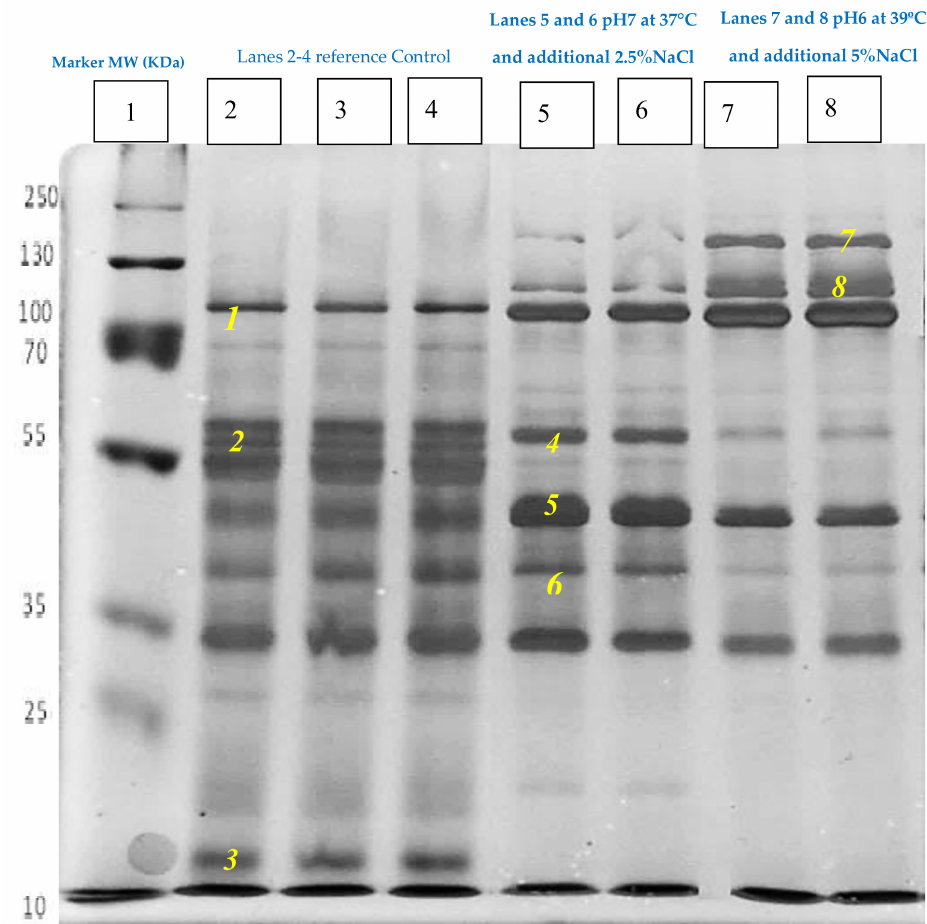
Figure 6. SDS-PAGE analysis of the stationary phase secreted proteins of S. aureus grown under the control conditions, compared with the two di ff erent experimental treatments. The numbers indicate the bands that were sliced for the identification by LC–MS /